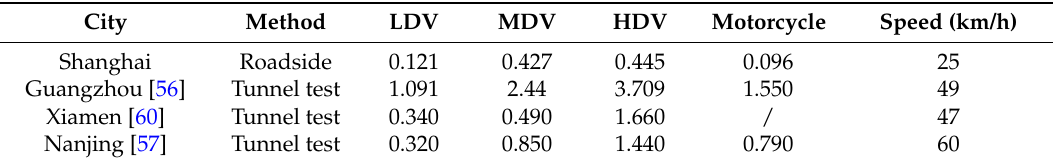
Table 6. Emission factors for different vehicle classes